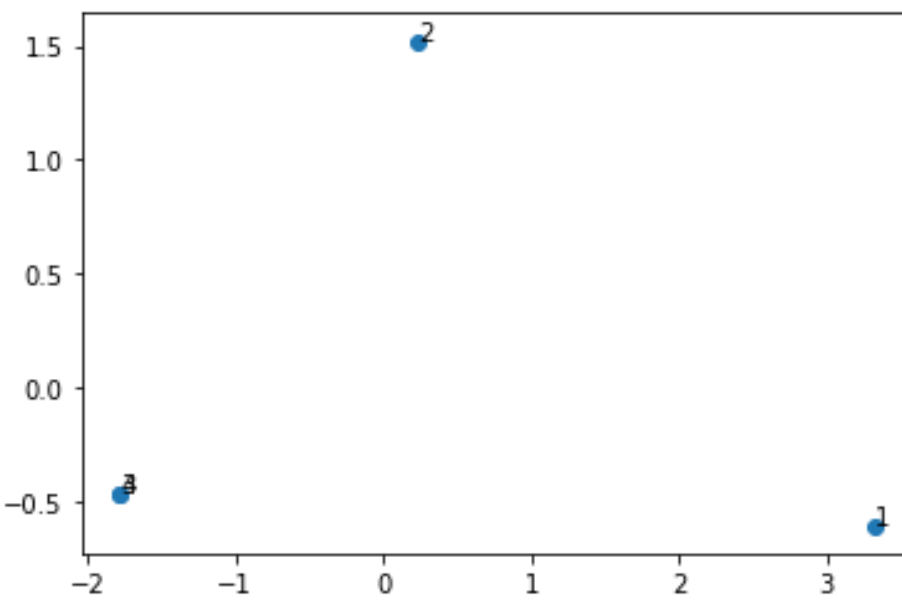
Figure 7. Embedding node of Q2, if ω ( u 3 ) = {{ 4,5 } , { 4 }} and ω ( u 4 ) = {{ 4,5 } , { 4 }}